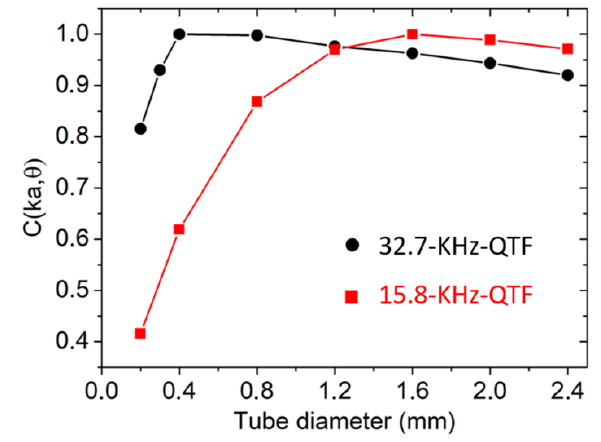
Figure 5. Normalized C ( ka, θ ) calculated as a function of tube diameter by using Equations (4) and (6), for the 15.8-kHz QTF and the standard 32.7-kHz QTF.